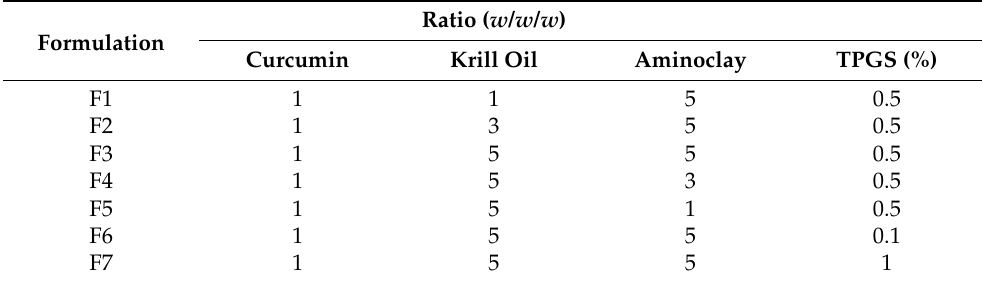
Table 1. Composition of the lipid-based solid dispersions.